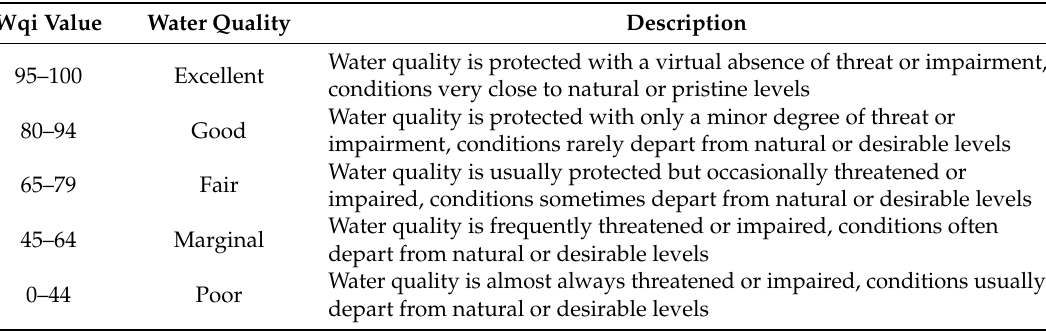
Table 1. Water quality rating